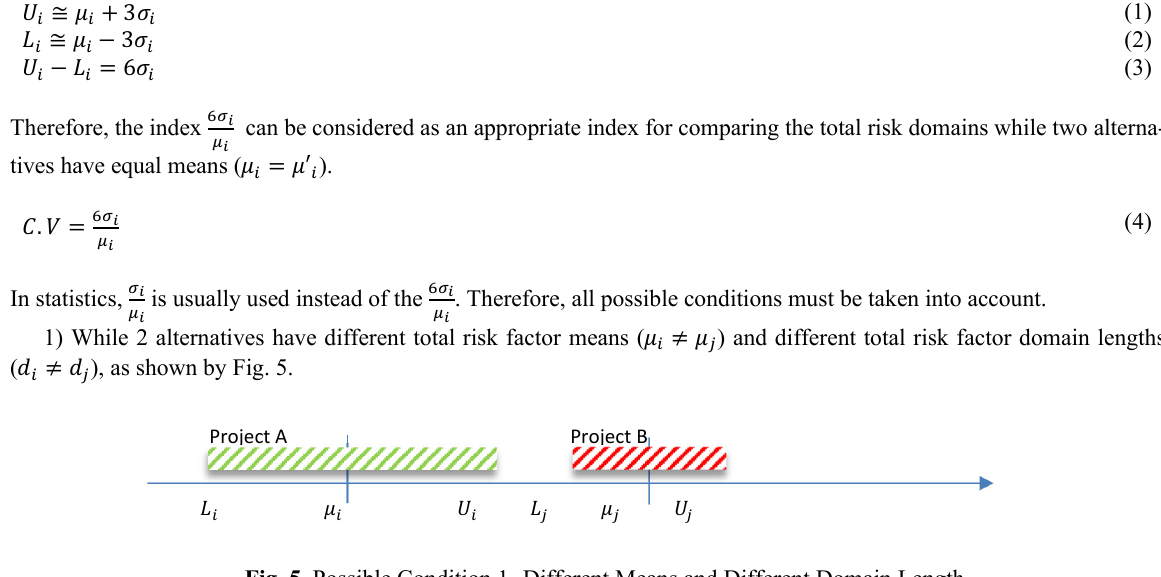
is more preferred 𝒊